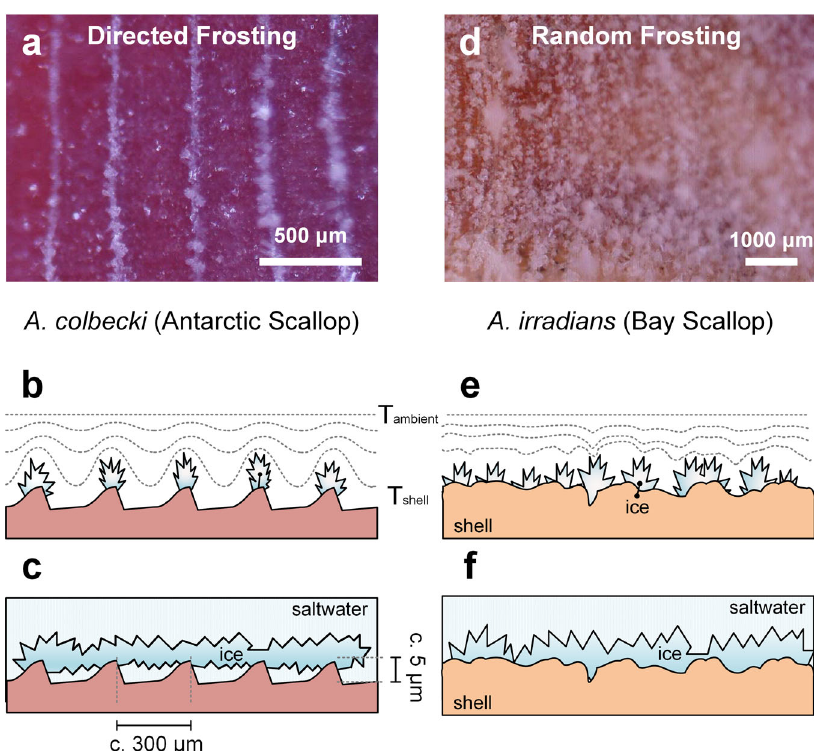
Fig. 4 In-air frosting of scallop shells. The progression of ice accumulation was observed for shells placed atop a cold source in a temperature- and humidity-controlled chamber (20 °C, 60% relative humidity). a The Antarctic scallop preferentially directed ice nucleation and subsequent growth to the shell ’ s growth rings, termed directed frosting. b This patterned ice accumulation may also apply to ice growth in underwater environments, where it could reduce overall ice-shell contact area ( c ). d Directed frosting was not observed in control species (e.g., Bay scallop), where ice accreted in a patchy or uniform fashion over the entire surface ( e ). Likewise, such random but homogenously distributed nucleation-growth behaviors are likely to apply for ice growth in underwater environments, with continuous ice mats over the surface of the shell establishing higher overall contact adhesion force ( f identical at different locations of the analyses, including along concentric growth rings, micro-ridges, or the micro-valleys in between. The surface roughness was determined using atomic force microscopy (AFM) and revealed that the peaks of the concentric growth rings were the roughest (RMS roughness of 135 ± 57 nm), followed by the radial micro-ridges (RMS rough- ness of 96 ± 3 nm). In contrast, valley fl oors between these micro- ridges were relatively smooth (RMS roughness of 38 ± 9 nm), interrupted only by small protuberances (nano-grains, diameter of 83 ± 26 nm) that were irregularly dispersed throughout the radial micro-valleys.